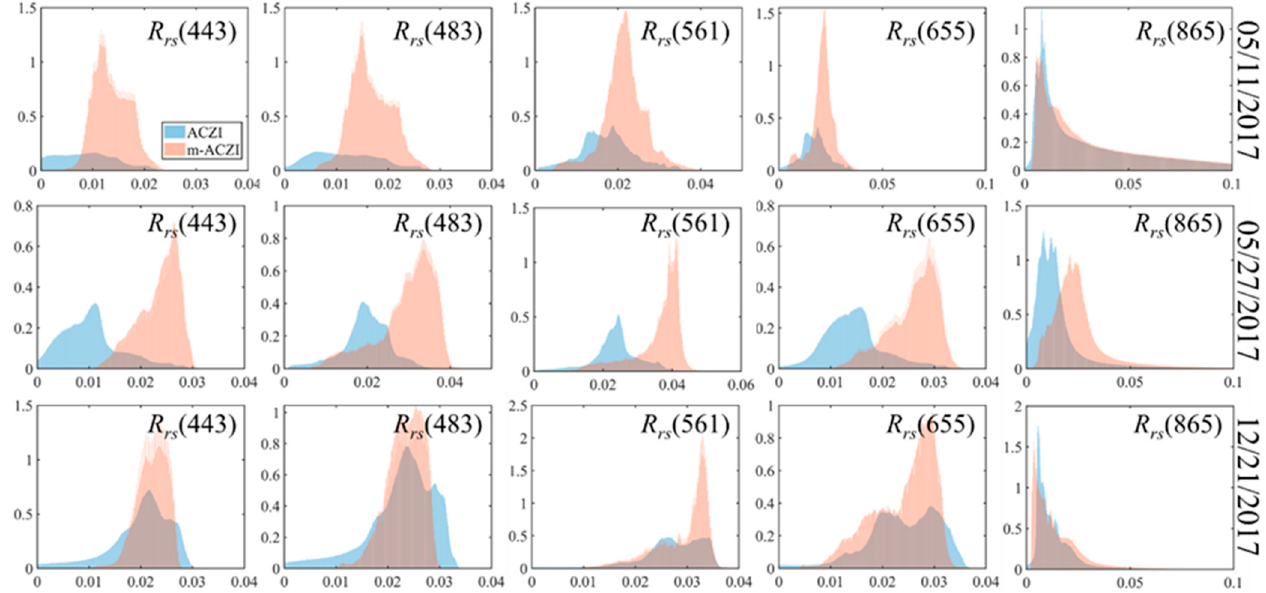
Figure 8. Frequency of R rs retrieved using the ACZI (blue) and the m-ACZI (orange) algorithm in Lake Taihu (Dates: 11 May 2017, 27 May 2017, and 21 December 2017). Lake Taihu (Dates: 11 May 2017, 27 May 2017, and 21 December 2017).